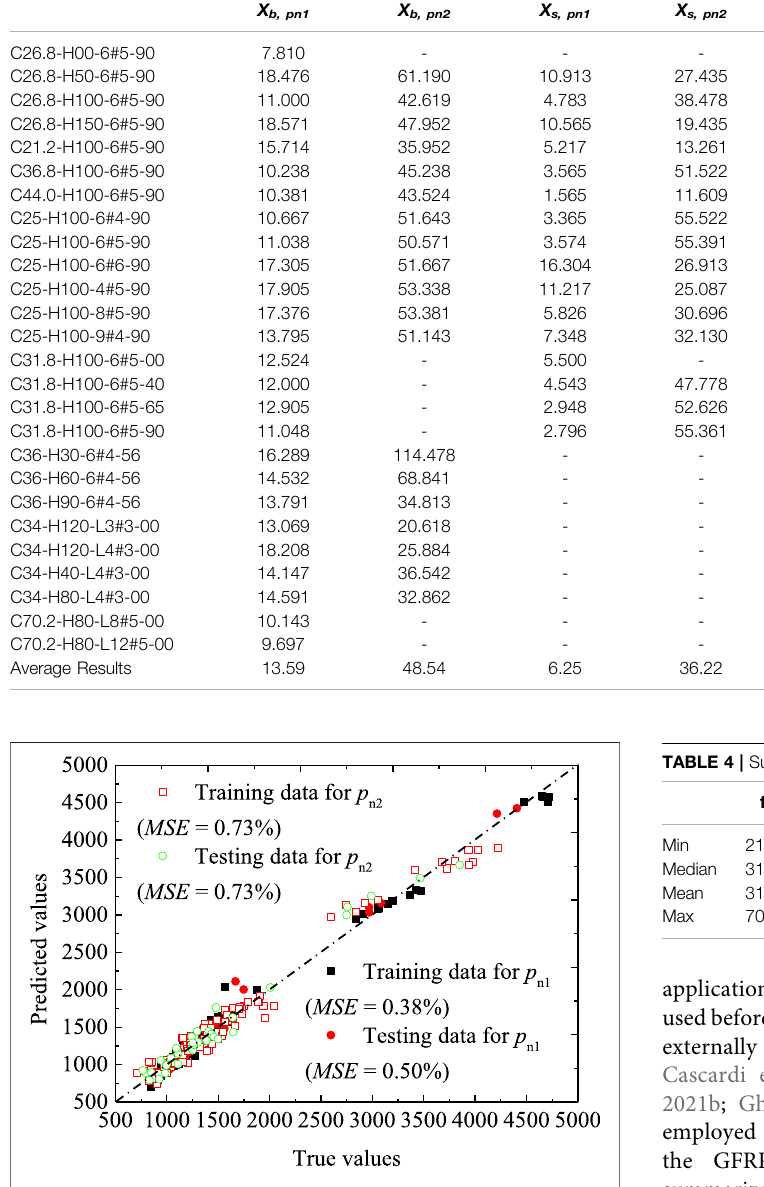
FIGURE 12 | Proposed linear model via the tested P n1 and P n2 .